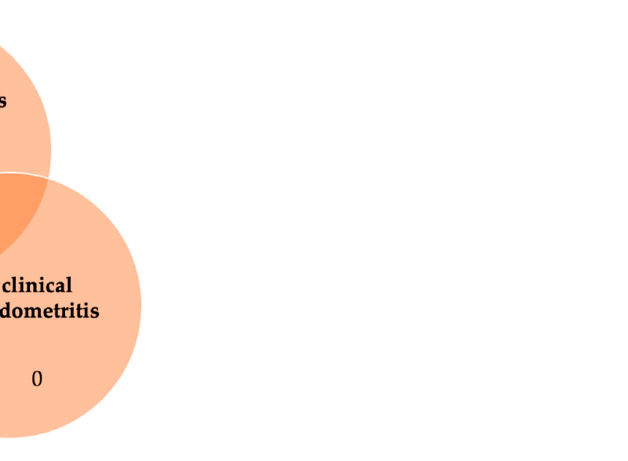
Figure 1. Relationships of inflammatory diseases of the uterus of dairy cows over the period of puerperium (n = 25). The numbers reflect the number of cows that suffered from one of the diseases or a combination of them; # : one cow left the farm prematurely in each case. Table 2. Incidences and results of preliminary reports of 46 dairy cows over the period of puerperium (until day 42